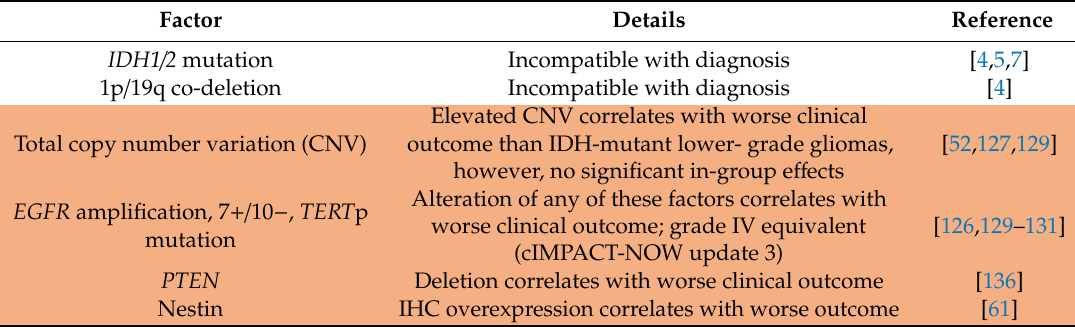
Table 4. Prognostic factors in IDH-wildtype histologically lower-grade